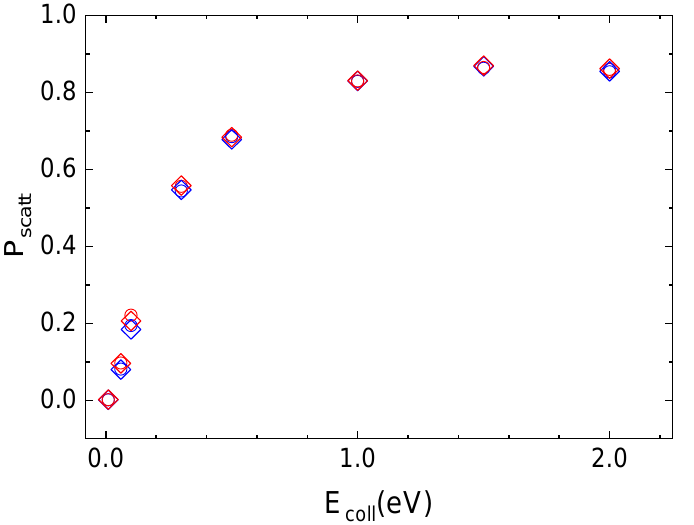
Figure 4. Inelastic probability for the roto-vibrational ground state of ortho (open circle) and para (open diamond) nitrogen molecules scattered by the quartz surface at T S = 100 K (blue symbols) and T S = 1000 K (red symbols).